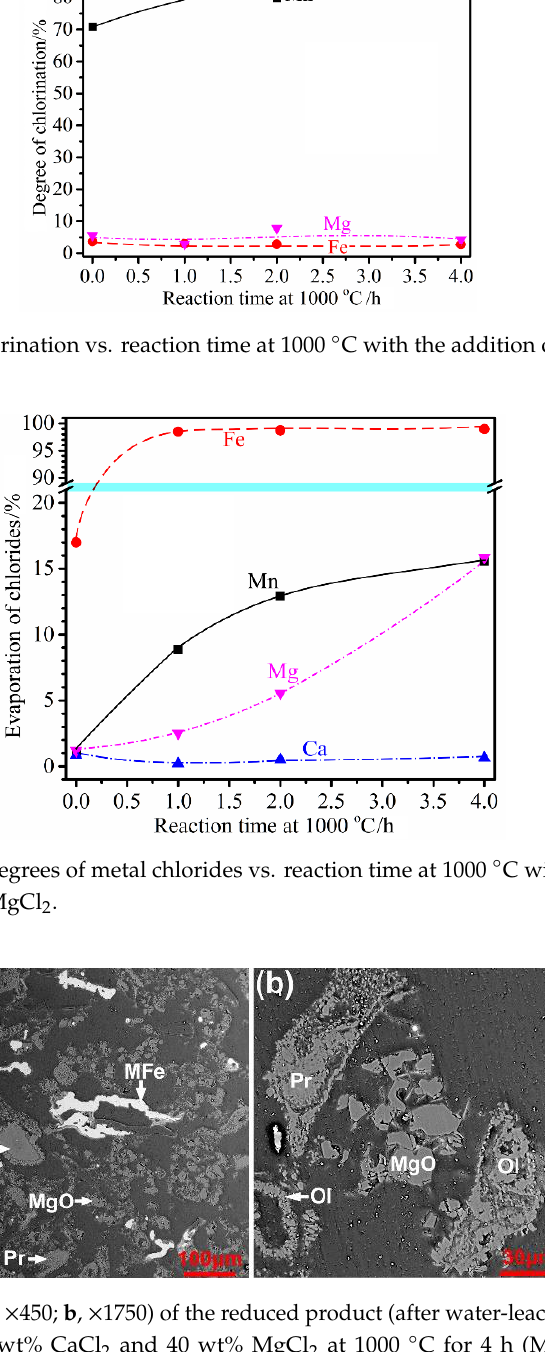
Figure 16. BSE images ( a , ×450; b , ×1750) of the reduced product (after water-leaching) from reduction with the addition of 20 wt% CaCl 2 and 40 wt% MgCl 2 at 1000 °C for 4 h (MFe: metallic Fe; Ol: olivine-type Mg 2 − x Mn x SiO 4 ; Pr: pyrope, Mg 3 Al 2 (SiO 4 ) 3 ).